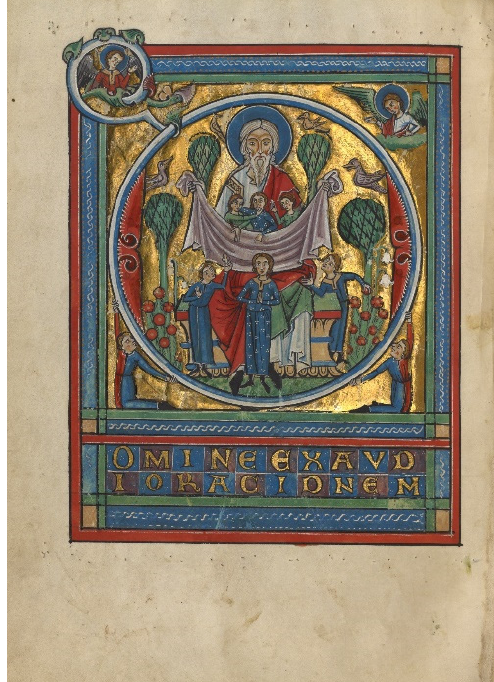
Figure 16. Initial D: Souls in the Bosom of Abraham, ca. 1240–1250, Ms. Ludwig VIII 2, fol. 113v, Los Angeles, The J. Paul Getty Museum.